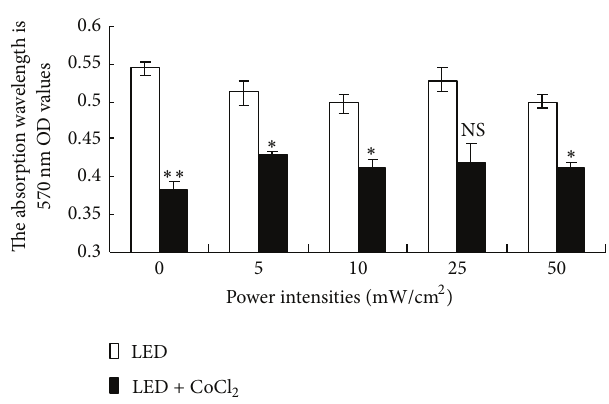
Figure 2: Effect of 808 nm LED light pretreatment with various power densities on cell viability in cultured neurons with 100 𝜇 M/L- CoCl 2 . Neurons were cultured in incubator at 37 ∘ C for 4h, the culture medium was removed, and then 200 𝜇 L of DMSO was added after 10min shaking before cell viability was measured. The power intensities chosen were 5, 10, 25, and 50 mW/cm 2 . Data are Means ± SEM. ∗∗ means that this group was highly significantly different from control group ( 𝑃 < 0.01 ). ∗ means that thisgroup has statistical difference with control group ( 𝑃 < 0.05